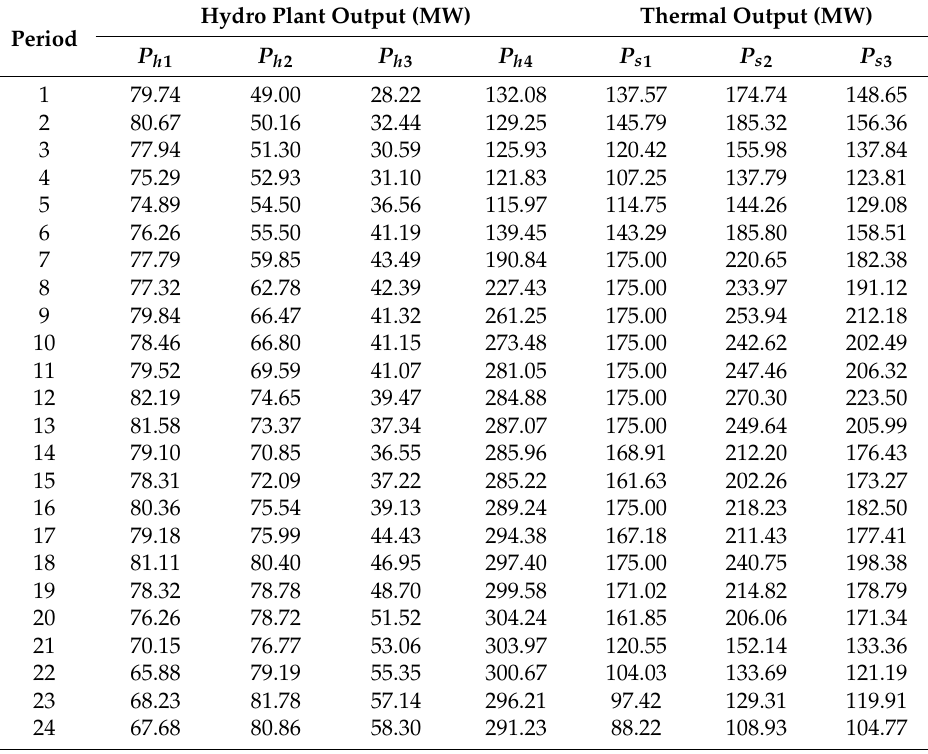
Table 2. The detailed results of scheme 15 by PMOGA for case 1.